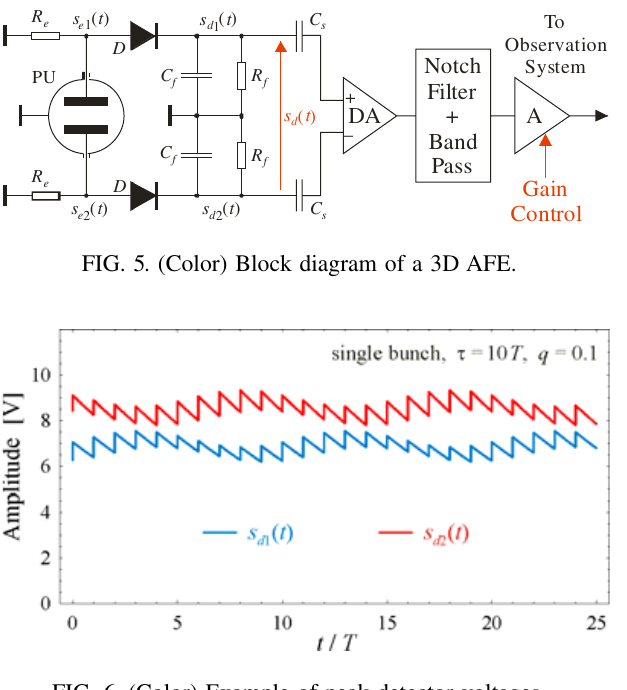
FIG. 6. (Color) Example of peak detector voltages.